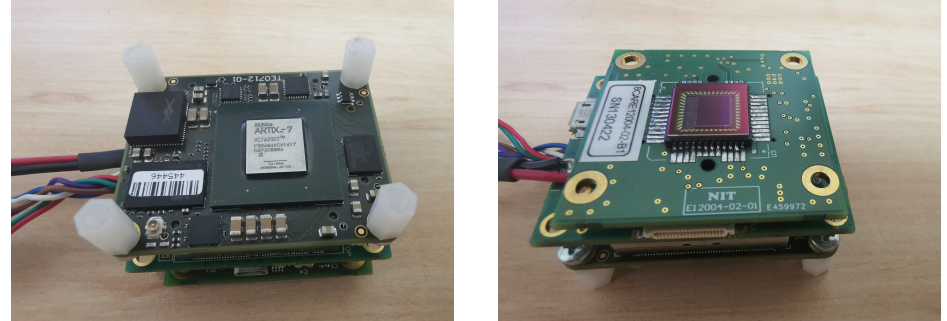
Figure 7. Hardware platform used to implement the SCoG-based